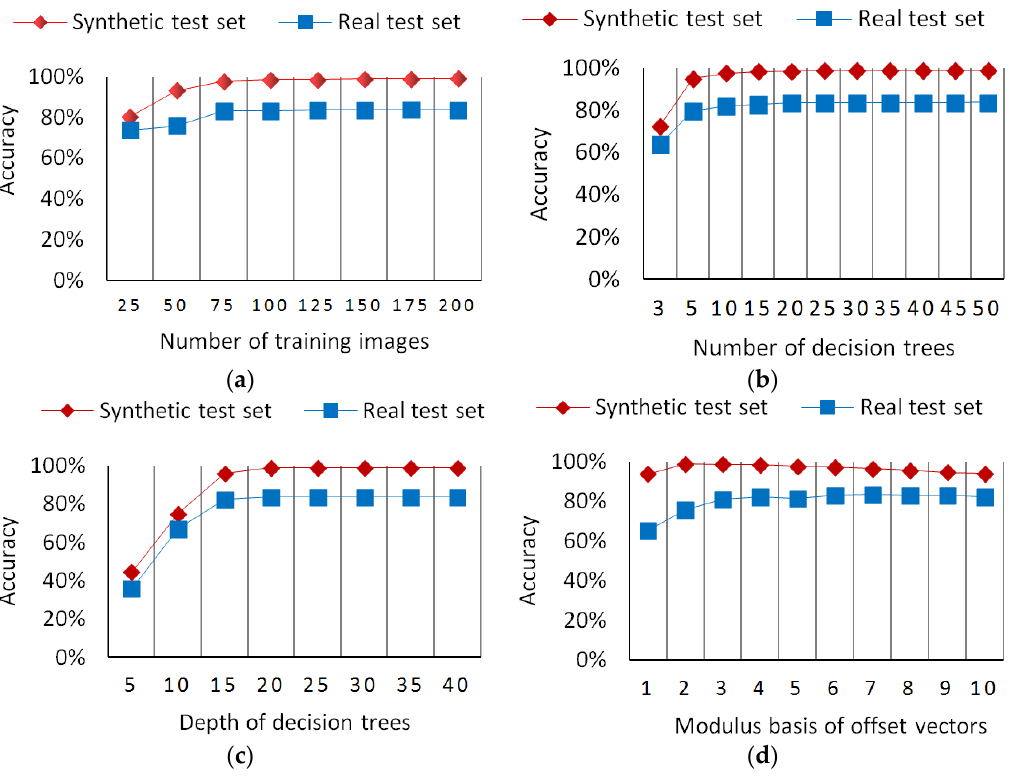
Figure 6. Training parameters vs. pixel classification accuracy. ( a ) Number of training images. ( b ) Number of decision trees. ( c ) Depth of decision trees. ( d ) Modulus basis of offset vectors.